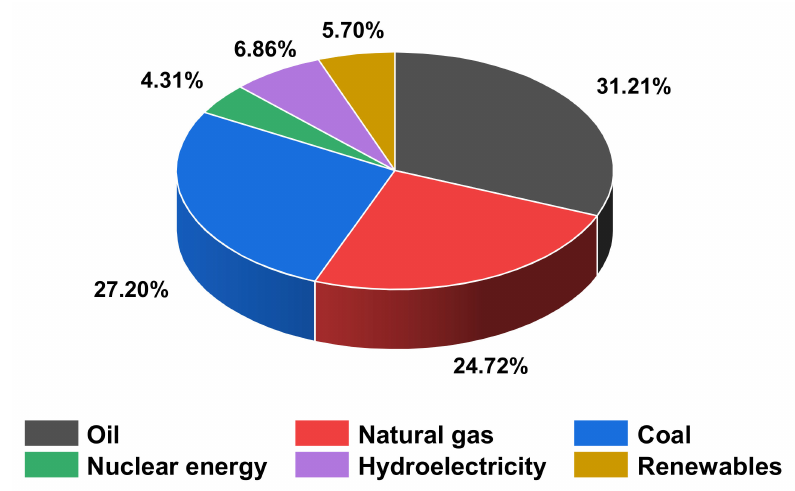
Figure 1. Primary energy: consumption by